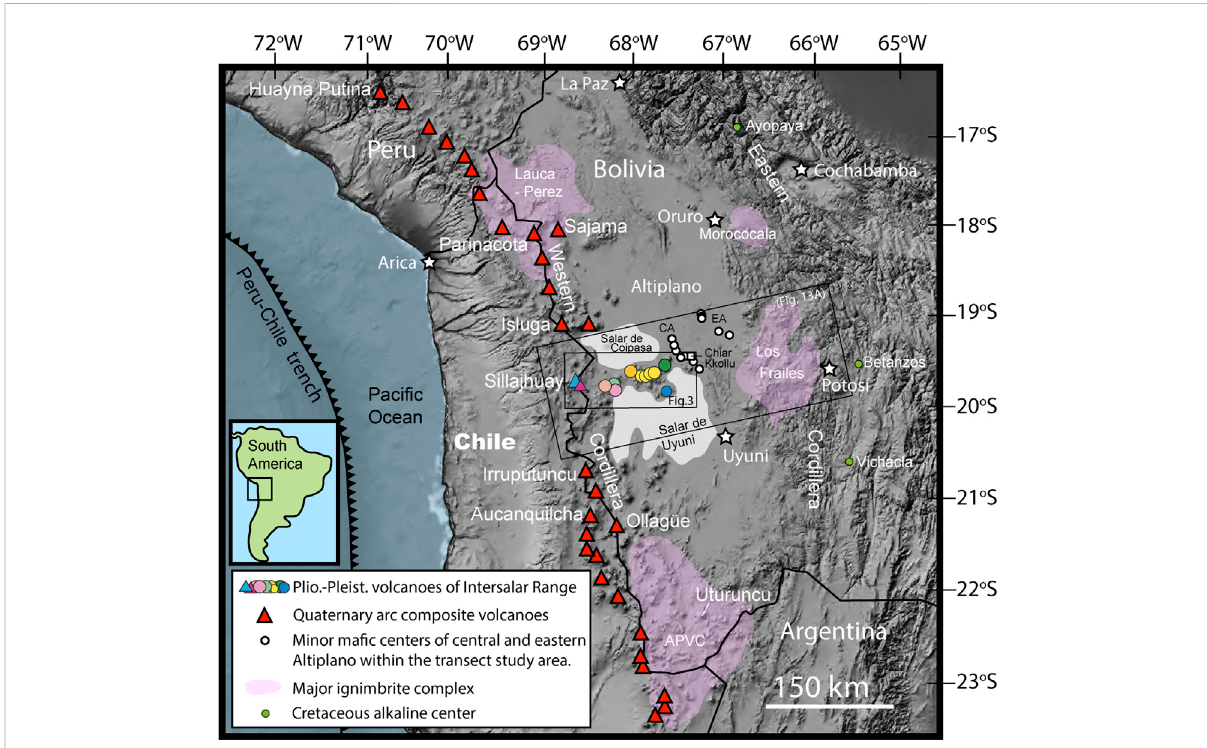
FIGURE 1 Location of the Intersalar Range volcanoes (colored symbols) of the Bolivian Central Andean Plateau in South America. Symbols are consistent in all subsequent fi gures. The labeled minor ma fi c centers of the central Altiplano (CA), eastern Altiplano (EA), and the Cretaceous-rifting related alkaline rocks of Ayopaya, Betanzos, and Vichacla are discussed in the text and included in subsequent fi gures for comparison with the data of this study. Not all volcanic centers in the map region are labeled in this fi gure. References in subsequent fi gures and text. Shaded relief digital elevation model (DEM) background image derived from 90 m resolution SRTM